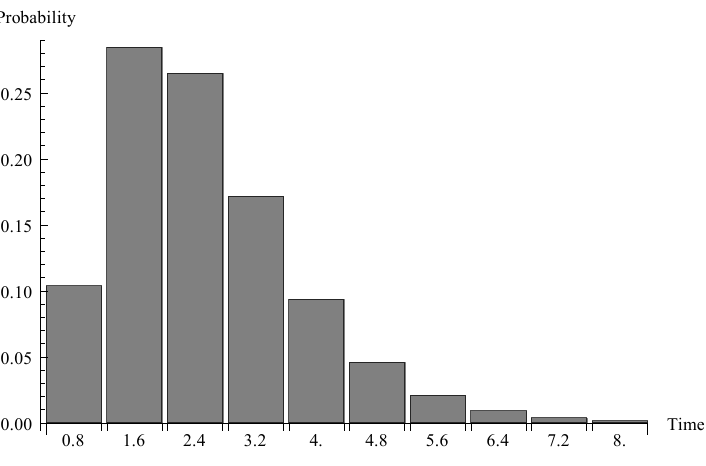
Figure 6. Distribution of idle period duration for λ =